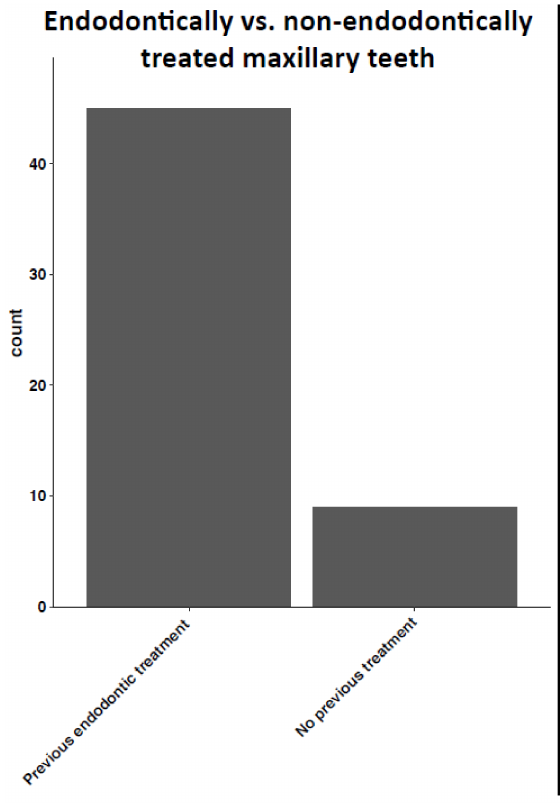
Figure 2. Radicular cyst found in endodontically versus non-endodontically treated maxillary teeth.